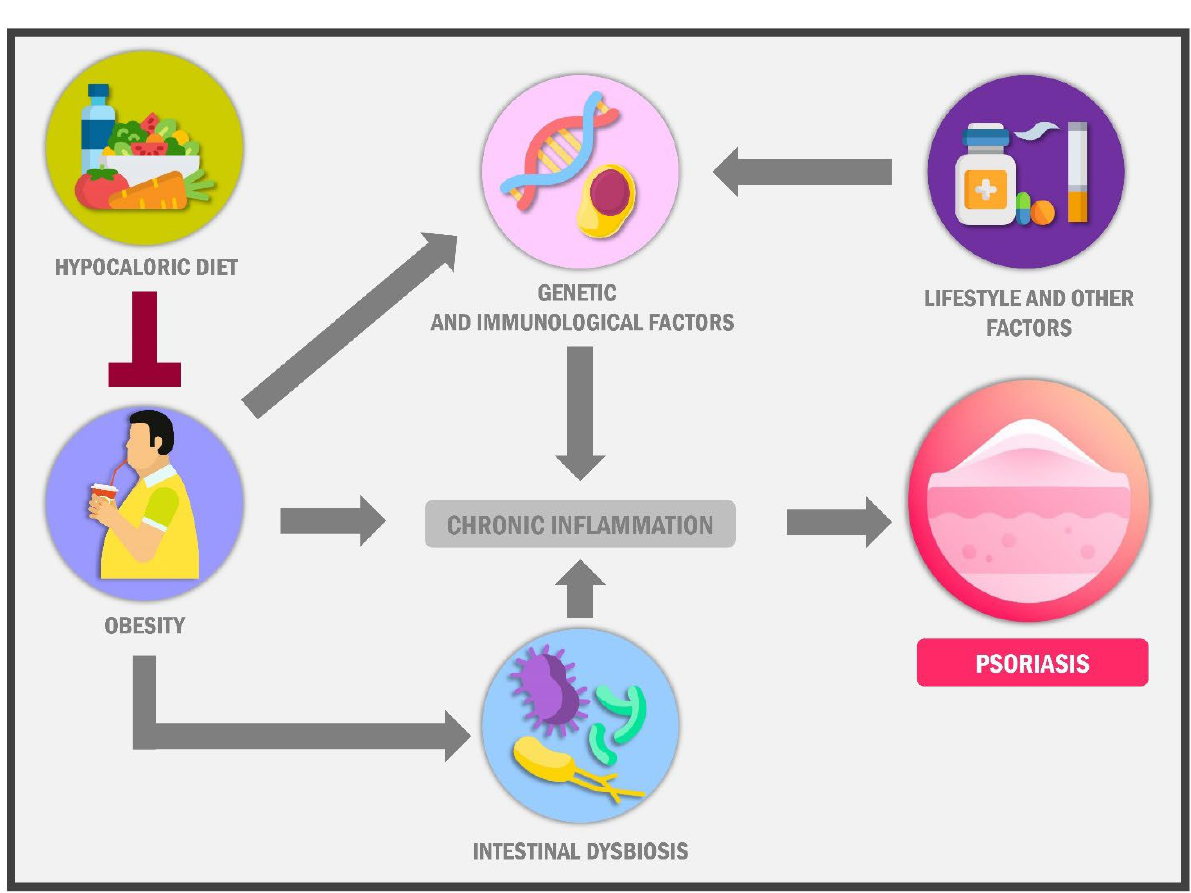
Figure 1. Biological factors involved in psoriasis pathophysiology. Obesity has been suggested as one of the mainstay factors of chronic inflammatory processes associated with psoriasis. Furthermore, it has been described how adipokines and pro-inflammatory cytokines contribute to psoriasis development from the sick adipose tissue. Obesity and a hypercaloric high-fat diet are linked to intestinal dysbiosis, leading to decreased intraluminal short-chain fatty acid production and local inflammation caused by the proliferation of “non-friendly” bacteria at gut epithelium leading to mucosal damage and increased permeability of gut mucosa. The damage to the gut mucosal layer subsequently causes pro-inflammatory cytokines release, leading to systemic inflammation. In turn, lifestyle factors and obesity alter gene expression and, thus, deregulation in critical immune cell functions like T-reg lymphocytes, Macrophages, and dendritic cells, exacerbating the inflammatory response. The persistence in this chronic not-solved systemic process plays a critical role in psoriasis pathogenesis.